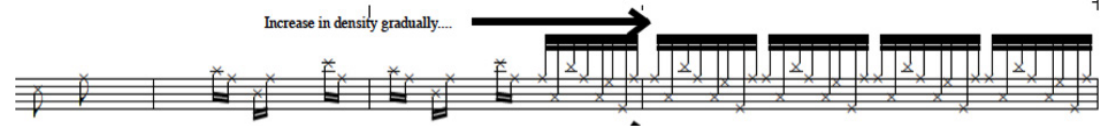
Figure 18. For prepared piano or played by plucking the strings inside the piano. The sparse sounds played by the pianist are imitated by the guitar, both gradually increasing in density and speed (Figure 19).